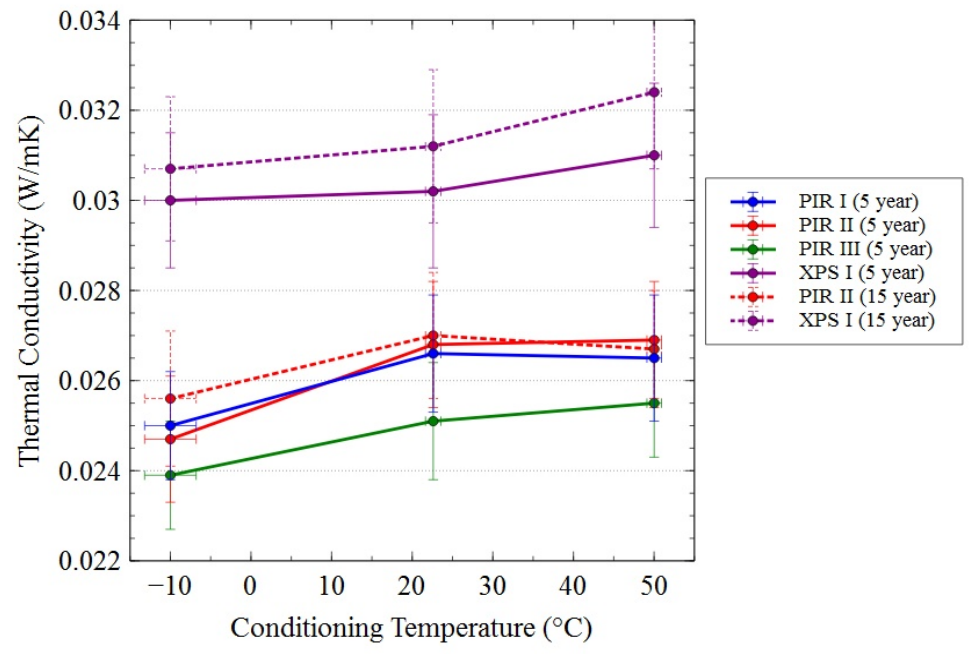
Figure 2. Effect of conditioning temperature on long-term thermal conductivity values for 5- and 15-years equivalent aging at a mean temperature of 24 ◦